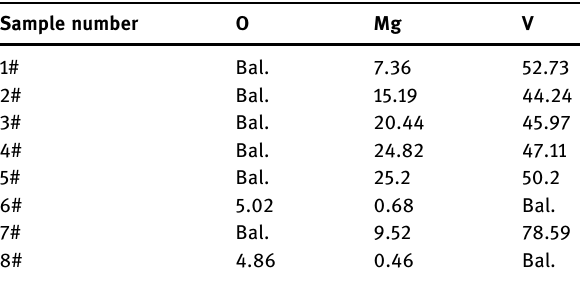
Table 2: Product composition analyses after acid leaching, mass %